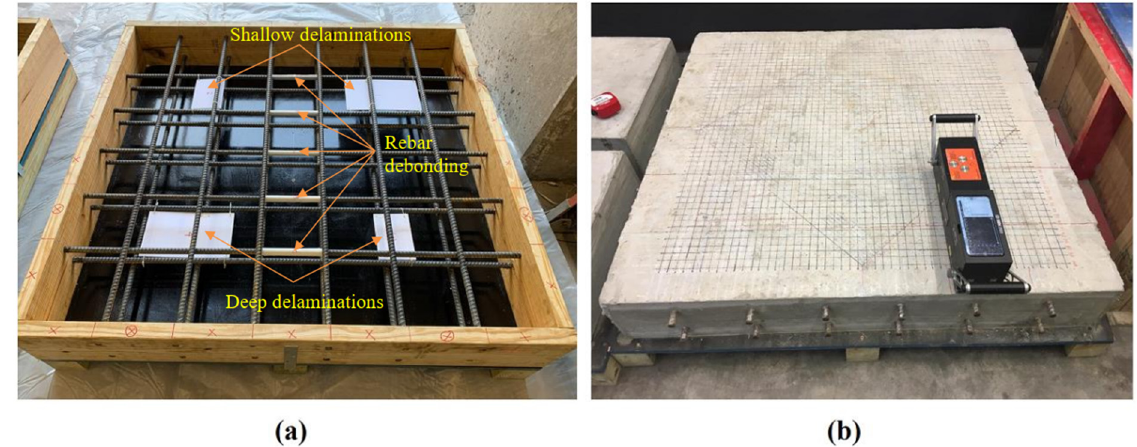
Figure 9. Slab 5: ( a ) before casting and ( b ) photo of MIRA data collection.